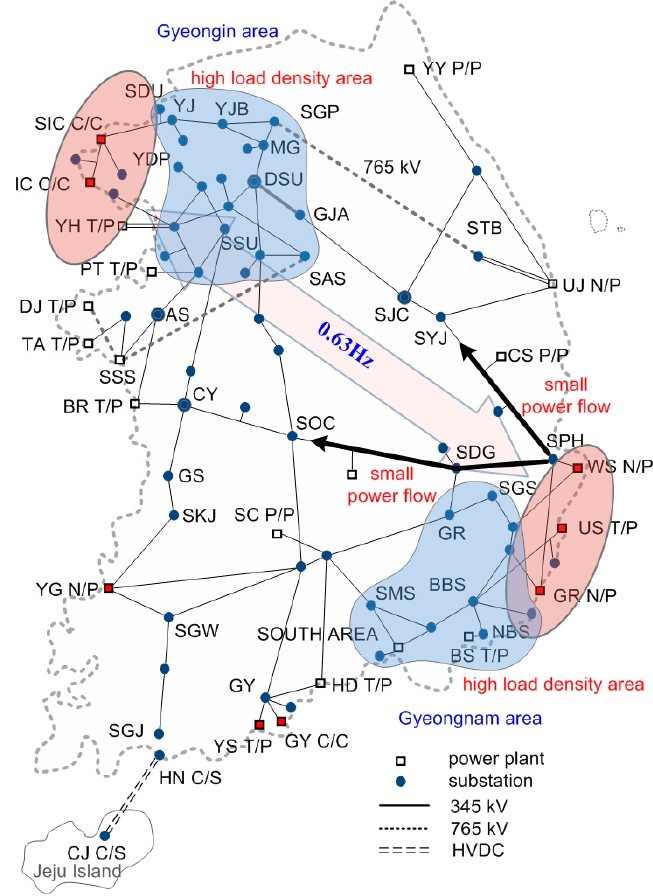
Figure 9. Simplified diagram of the Korea Electric Power Corporation (KEPCO) system.